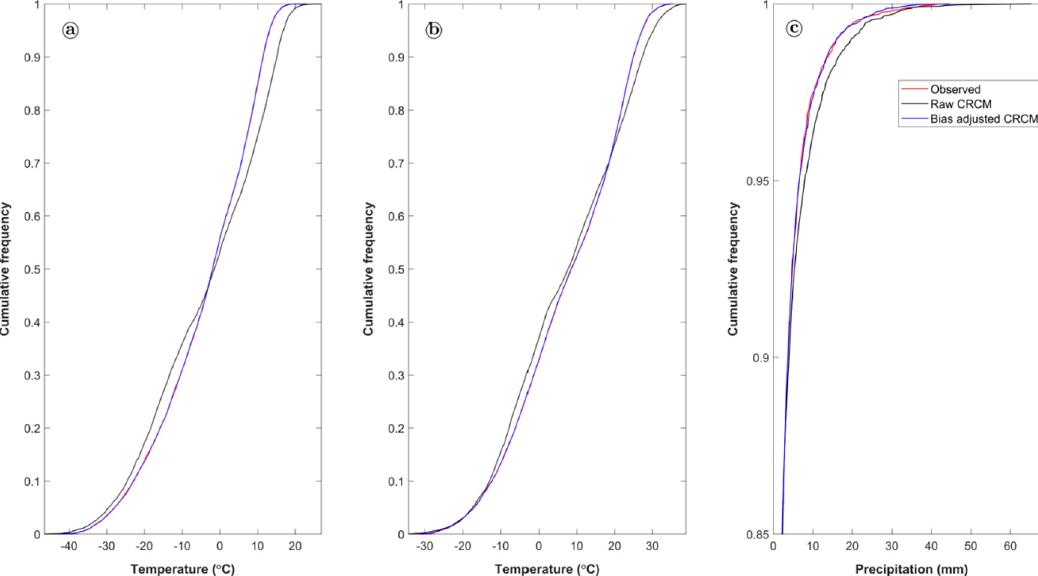
Figure 3. Cumulative distribution of observed, raw Canadian Regional Climate Model (CRCM) and bias-adjusted CRCM data averaged across the basin for ( a ) minimum temperature, ( b ) maximum temperature, and ( c ) precipitation for the period 1981–2010.